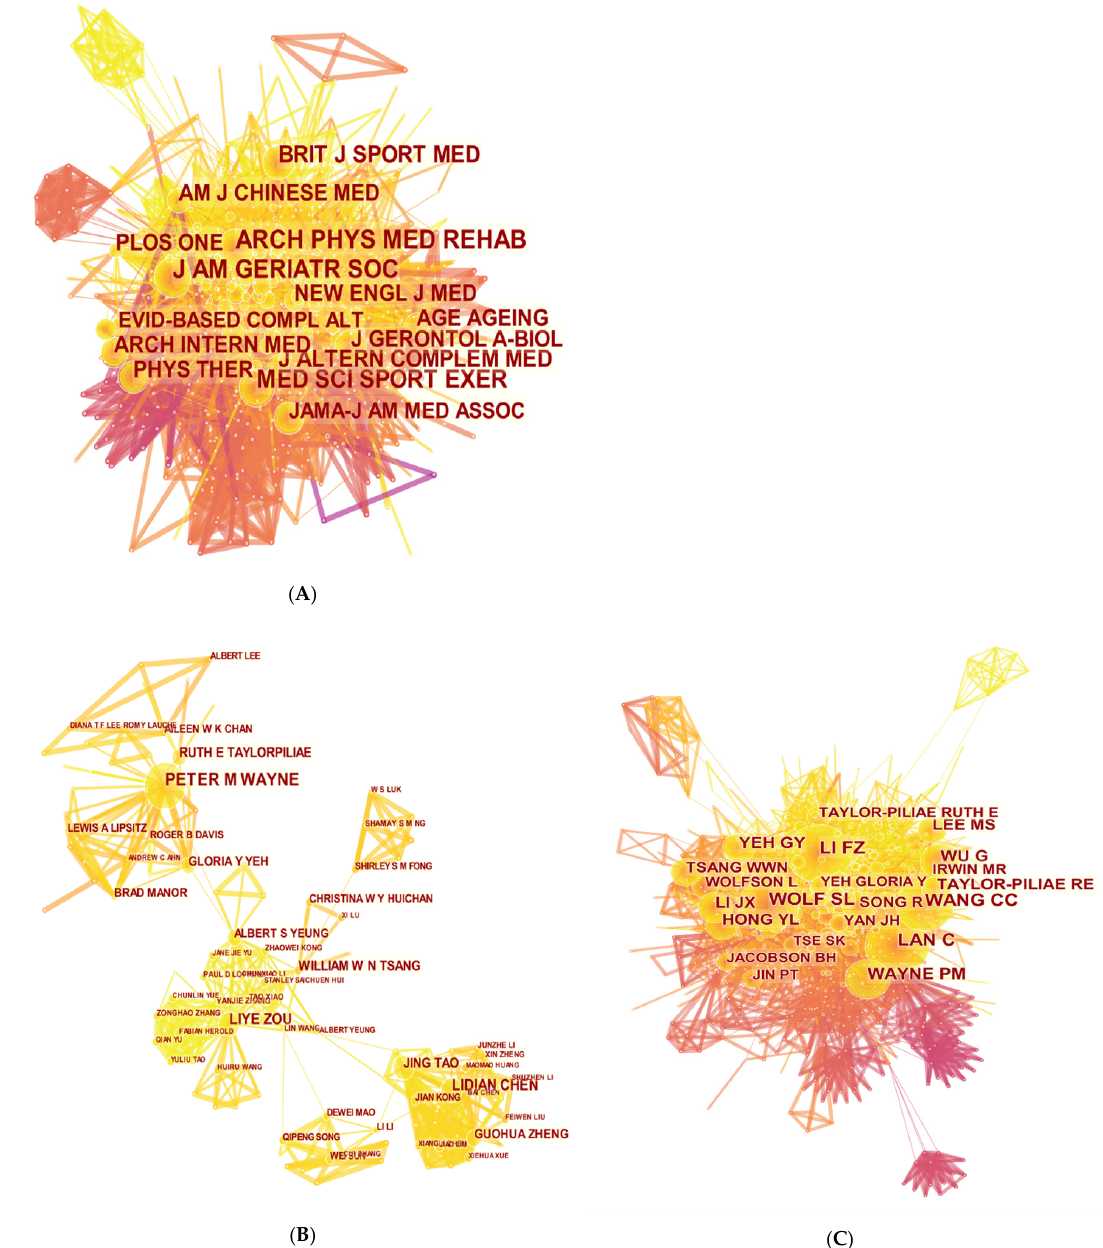
Figure 3. ( A ) Map of active journals with publications in the field of Tai Chi research; ( B ) Map of active authors with publications in the field of Tai Chi research; ( C ) Map of active co-cited authors with publications in the field of Tai Chi